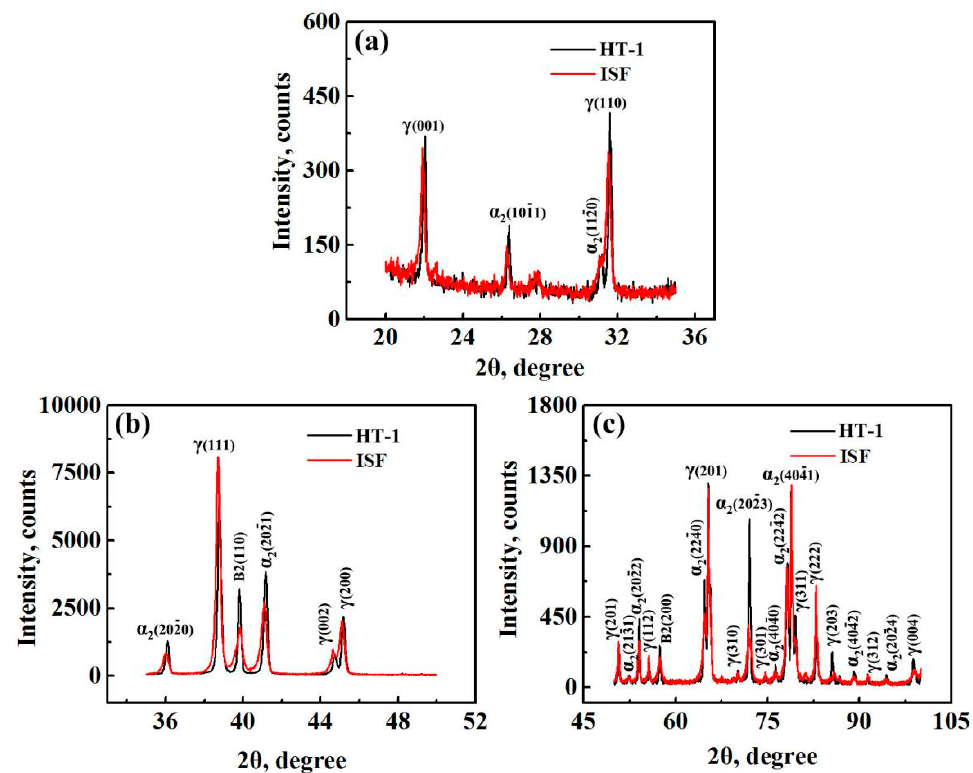
Figure 3. Comparison of X-ray di ff raction (XRD) patterns between the samples in the states of isothermal forging (ISF) and isothermal forging + 1000 ◦ C / 1 h / AC (HT-1) ( a ) 20 ◦ < 2 θ < 35 ◦ ; ( b ) 35 ◦ < 2 θ < 50 ◦ ; ( c ) 50 ◦ < 2 θ < 100 ◦